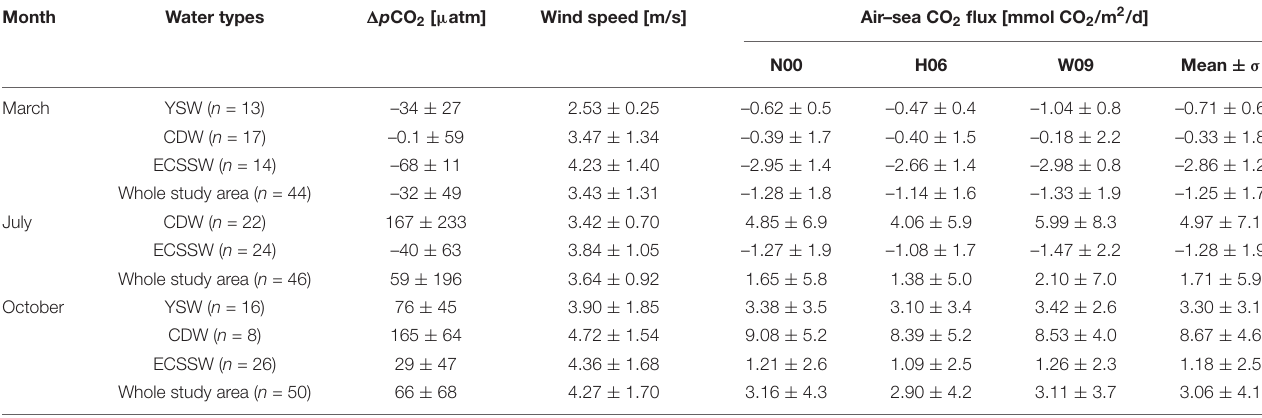
TABLE 1 | Surface water average (cid:49) p CO 2 ( µ atm) and F CO 2 (mmol CO 2 /m 2 /day) using three different gas transfer velocity ( k ) formulas for the water types in March, July, and October,